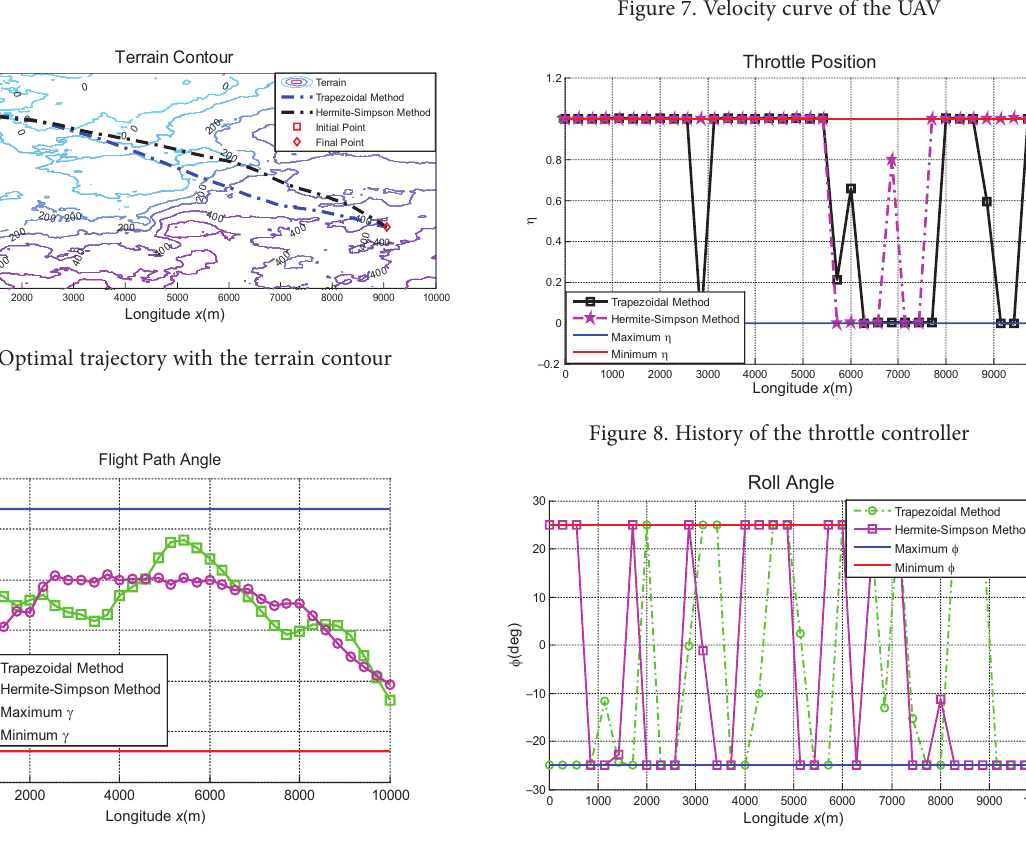
Figure 5. Curve of the flight path angle